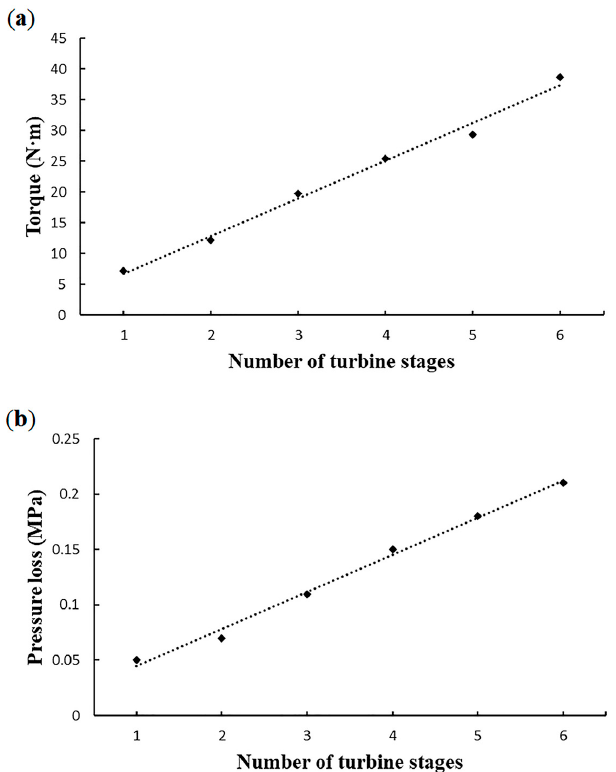
Figure 7. Torque and pressure loss results of 1–6 turbine stages. ( a ) torque results; ( b ) pressure loss results.